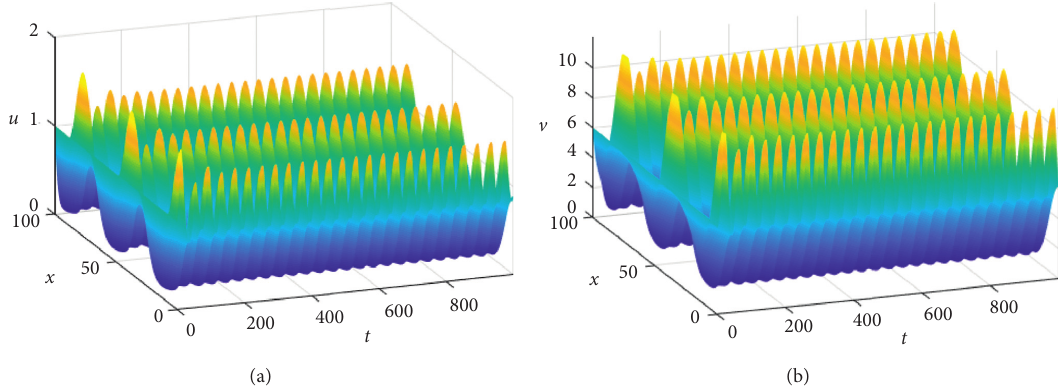
Figure 6: Numerical solutions of system (6a)–(6c): (a) prey population u and (b) predator population v .